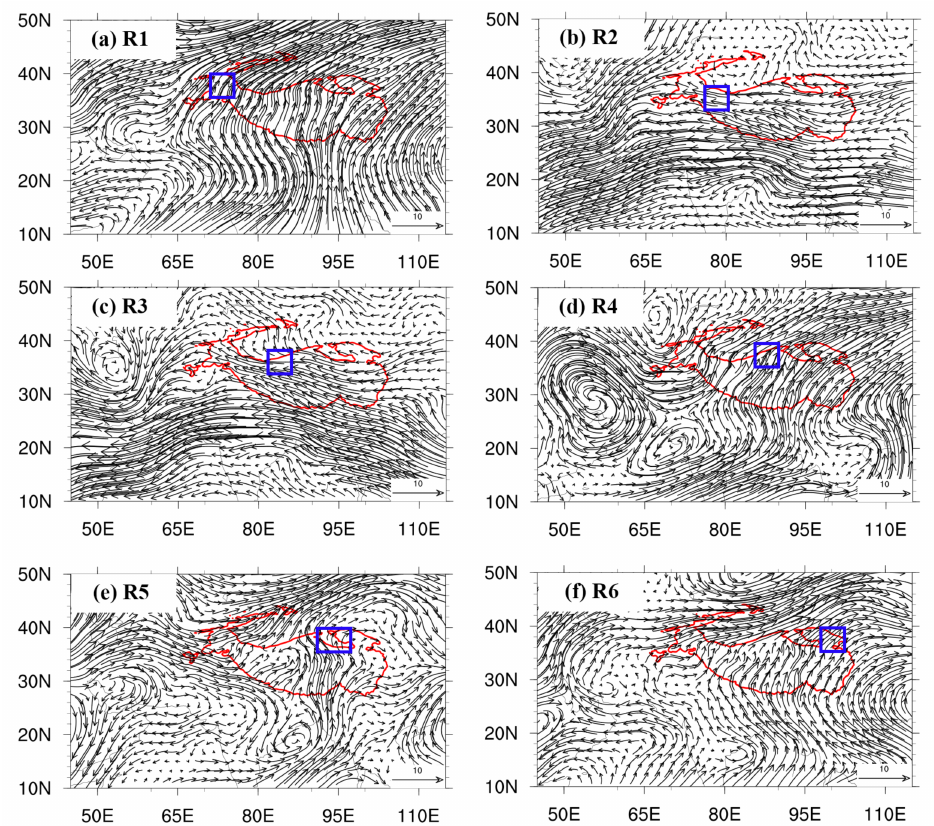
Figure 6. The spatial distributions of composed ERA5 wind at 500 hPa, which were averaged over two days in advance of the extreme precipitation events controlled by the Asia Monsoon over the six subregions. Blue rectangles in the panels ( a–f ) represent the subregions, respectively.